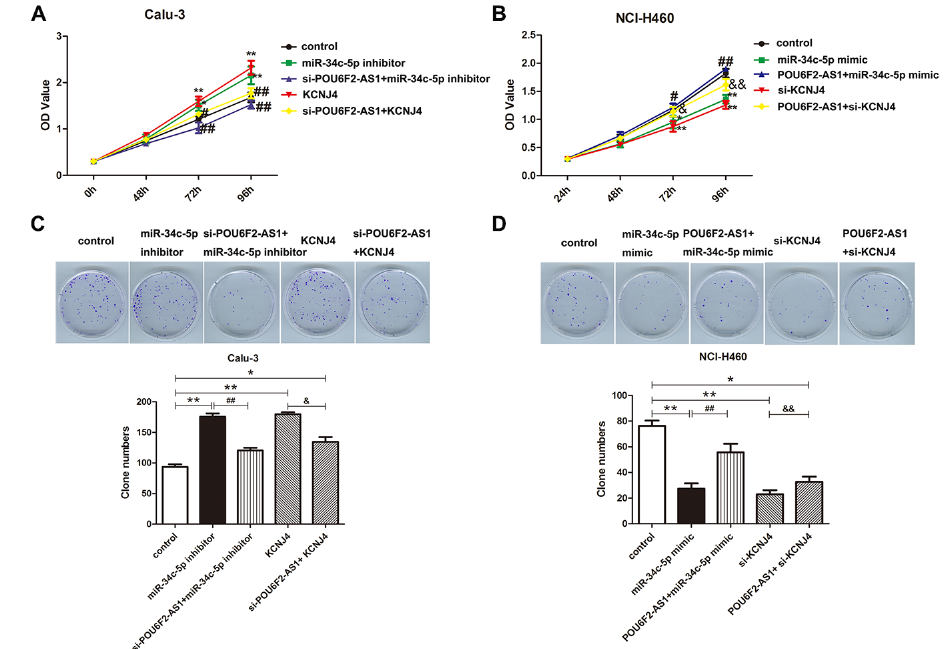
Figure 4 – Effect of POU6F2-AS1 on cell proliferation and colony formation in LADC cells was reversed by miR-34c-5p via targeting KCNJ4. (A and B) CCK-8 and (C and D) colony formation assay were implemented to investigate proliferative and colongenic capabilities, respectively. *P < 0.05, **P < 0.01, ## P < 0.01 and & P <